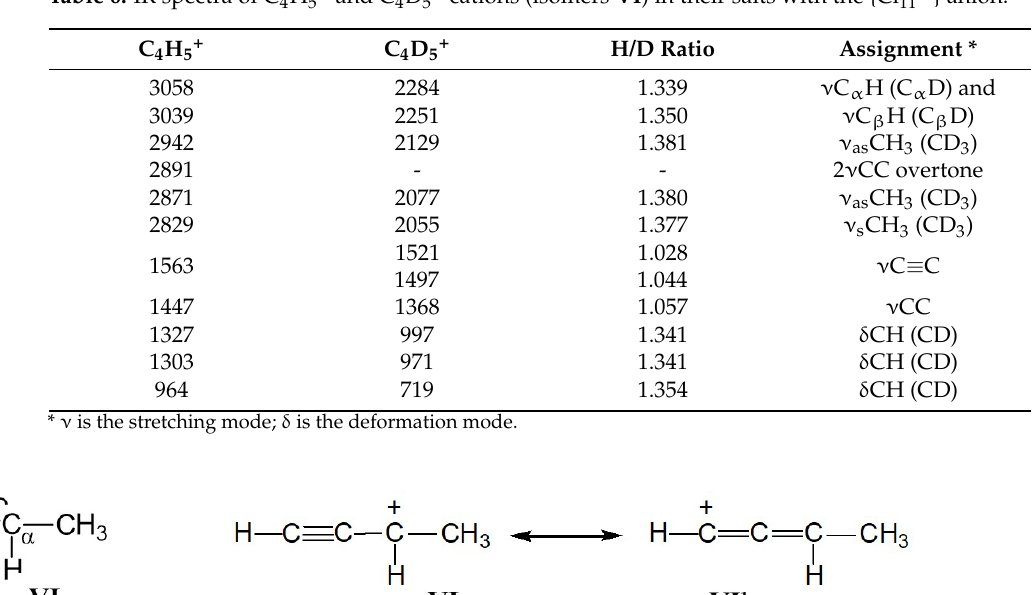
Scheme 5. Proposed formation of the C 4 H 5+ cation from the chloronium cation.